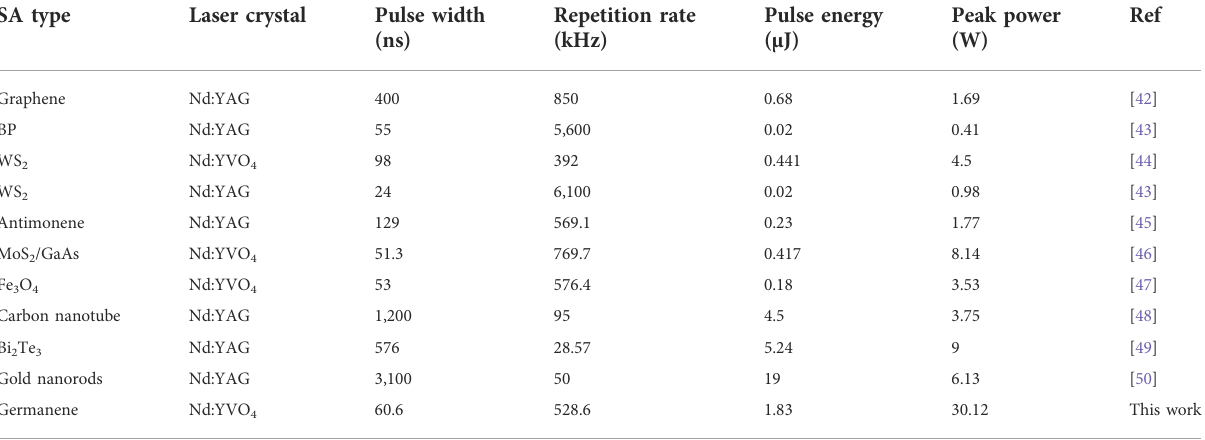
TABLE 1 Passively Q-switching performances for the 1064 nm solid-state laser with different 2D SA materials. SA type Laser